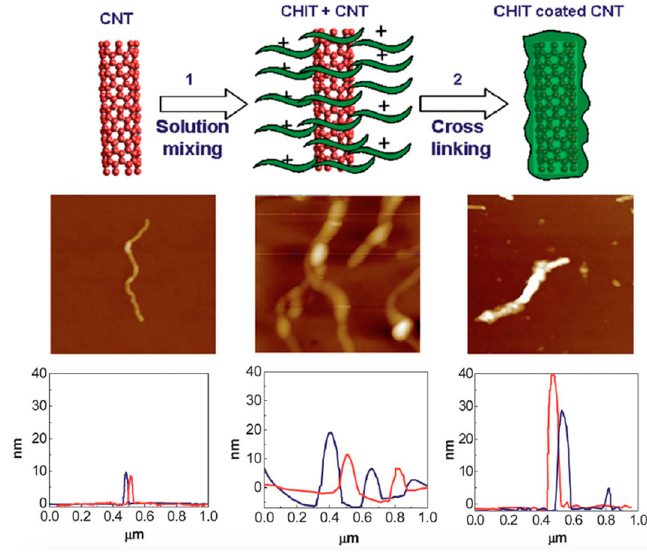
Figure 11. Schematic representations of Chit-f-CNT preparation ( top ), corresponding AFM height images ( middle ) and profile measurements ( bottom ) for pure CNT ( left ), Chit non-covalent functionalized CNT ( center ) and Chit covalently linked CNT ( right ).